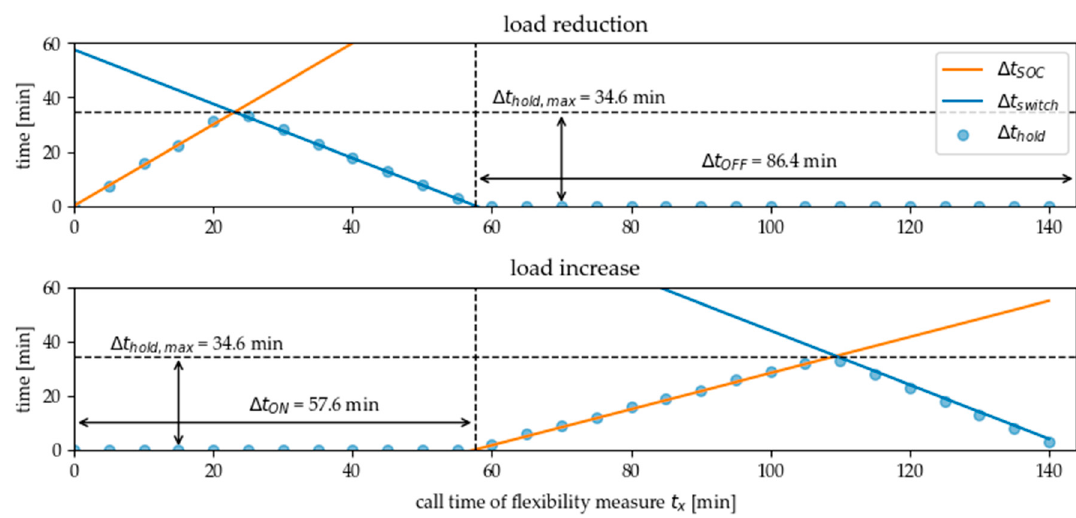
Figure 10. Holding time of the flexibility measure in dependence of the call time of the flexibility measure within one charging cycle. In normal operation the energy converter is switched on from time step 0 to 57.6, thus the measure of load reduction is available in this period. Load increase can only be called in the second part of the charging cycle